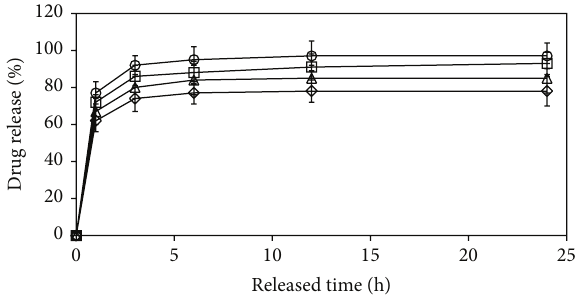
Figure 6: In vitro drug release profiles of drug-loaded blend microparticles prepared with starch/gelatin blend ratios of ( ⬦ ) 0/100, ( Δ ) 20/80, ( ◻ ) 35/65, and ( I ) 50/50 (w/w) crosslinked with 25 g glutaraldehyde/100 g